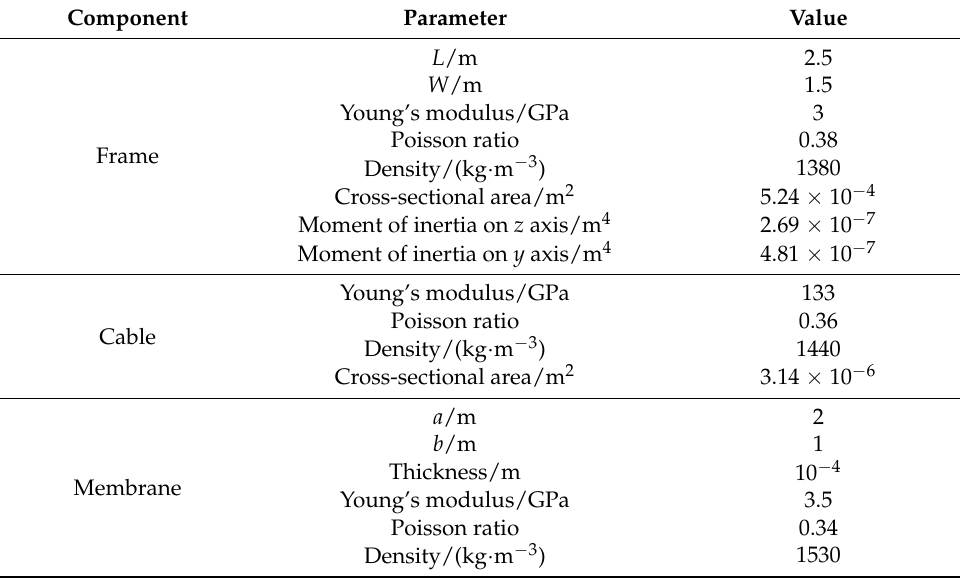
Figure 3. Mode shapes of the membrane antenna. ( a ) the 1st mode, ( b ) the 2nd mode, ( c ) the 3rd mode, ( d ) the 4th mode. Table 1. Materials and geometric parameters of the membrane